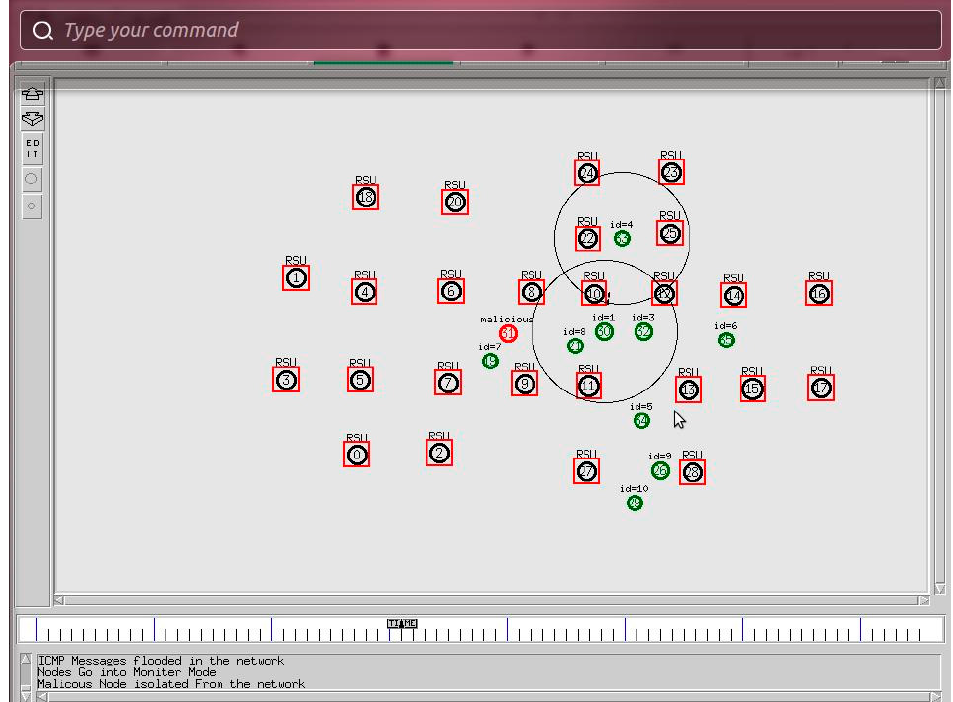
Figure 5. Malicious node isolated in the network.